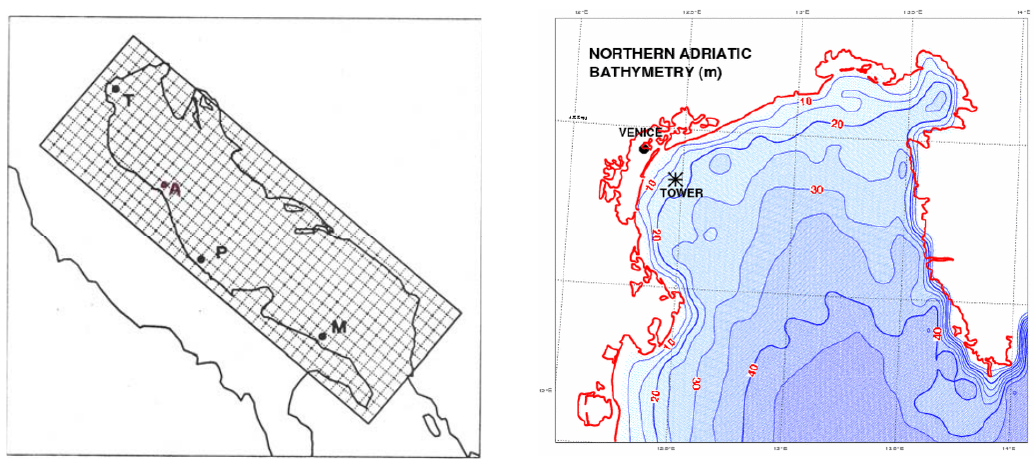
Figure 3 – Left panel: geometry of the Adriatic Sea and location of the ISMAR oceanographic tower (see Figure 2), and the A=Ancona, P=Pescara, M=Monopoli wave measuring buoys. Right panel: bathymetry of the northern part of the basin. The grid in the left panel shows the field orientation in Figure 4.